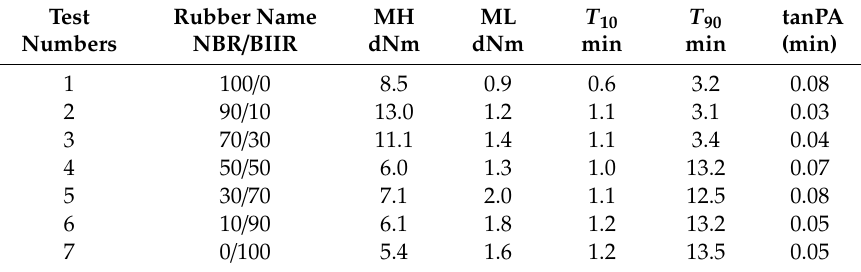
Figure 6 . Curves of vulcanization characteristics for NBR/BIIR with various blend ratios. Figure 6. Curves of vulcanization characteristics for NBR / BIIR with various blend ratios. Table 2. Vulcanization characteristics of NBR / BIIR with various blend ratios (150 ◦ Table 2. Vulcanization characteristics of NBR/BIIR with various blend ratios (150 °C).